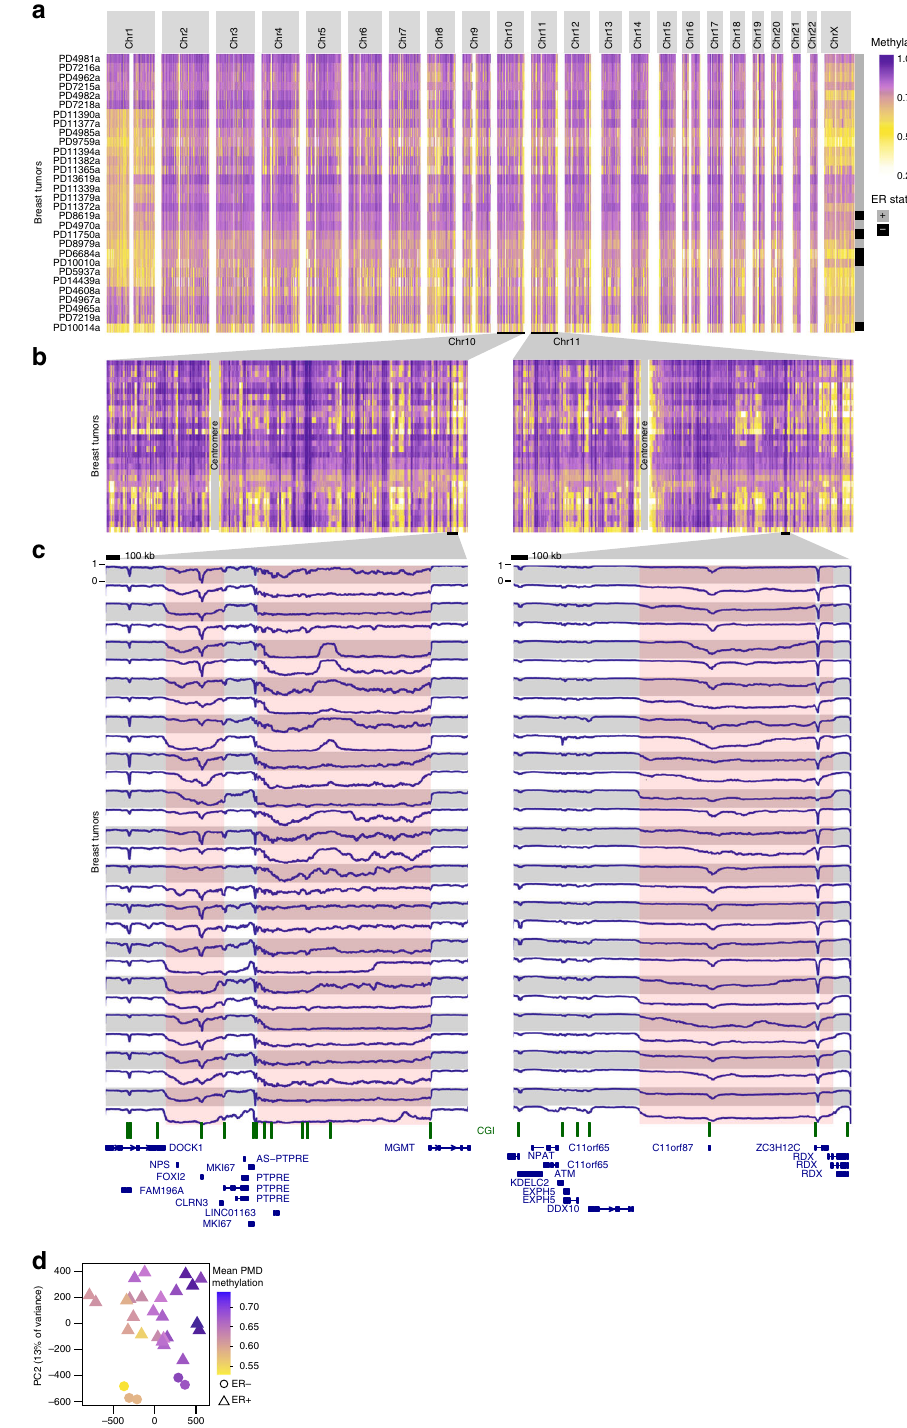
Fig. 1 Visualization of inter-tumor variation at genome-wide scale. a Genome-wide and b chromosome-wide maps of WGBS DNA methylation pro fi les from 30 breast tumor samples. Mean methylation is displayed in consecutive tiles of 10 kb (see Methods section). Ordering of tumor samples is according clustering of the tiled pro fi les. c WGBS DNA methylation visualization at megabase-scale. Pink coloring indicates common methylation loss (PMDs), although tumor-speci fi c PMD borders vary. A scale bar (100 kb) is shown at the top of each panel. CpG islands are indicated in green. d Principal component analysis of WGBS DNA methylation pro fi les (see Methods section). Each tumor sample is represented with its estrogen-receptor (ER) status (point shape) and mean PMD methylation (point